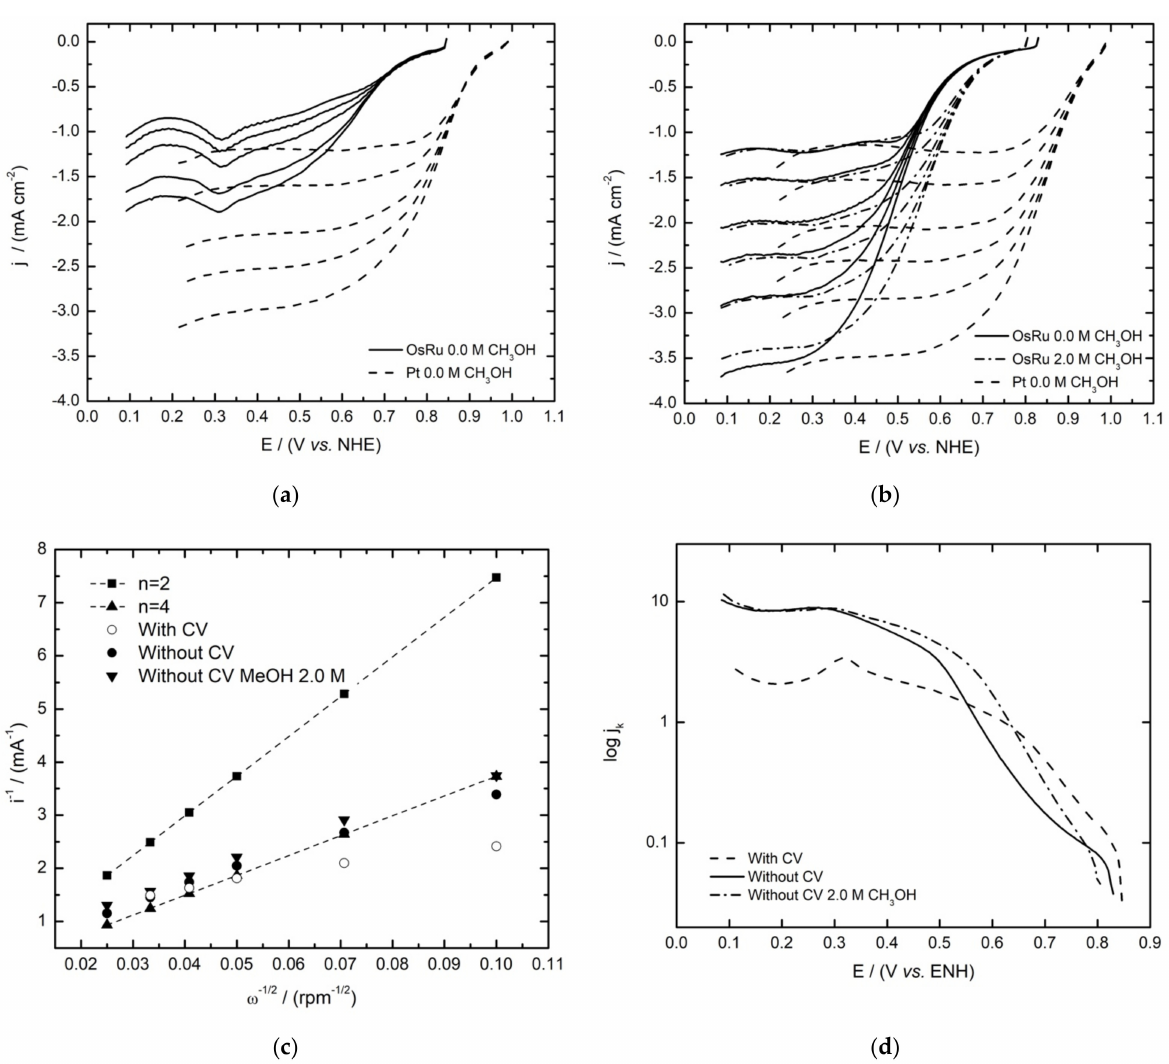
Figure 7. Oxygen reduction reaction polarization curves of the OsRu electrocatalyst compared with 30 wt% Pt/Vulcan XC-72 ( a ) with and ( b ) without ink activation, in the absence and presence of methanol, with its respective ( c ) Koutecky–Levich plots and ( d ) mass-corrected Tafel plots with ink activation in the absence of methanol and without ink activation in the absence and presence of methanol solution for the OsRu electrocatalyst. The electrolyte was 0.5 mol L − 1 H 2 SO 4 and the sweep rate 5 mV s − 1